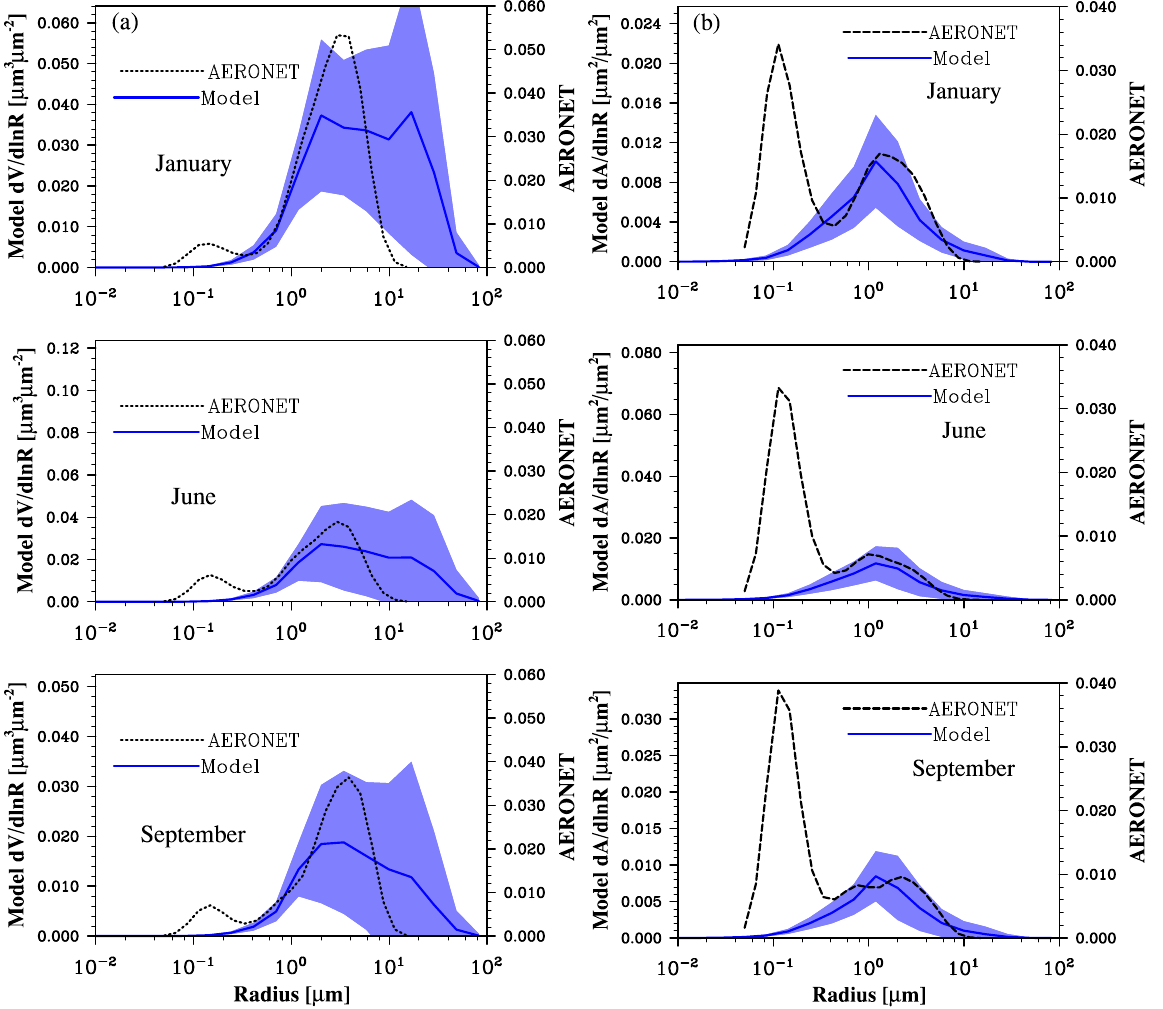
Fig. 14. (a) volumetric size distribution s a function of wet radius compared between the vertical integration of the simulations and AERONET inversion product at Midway Island in March, June, and September 2006. The shaded area around the model curve is one standard deviation of all the daily size distributions; (b) same as (a) but for cross-sectional area size distribution. The model used the CMS source function and a solubility factor of 0.5. Different vertical scale are used for the model and AERONET to make the total volume and cross-sectional area the same for particles larger than